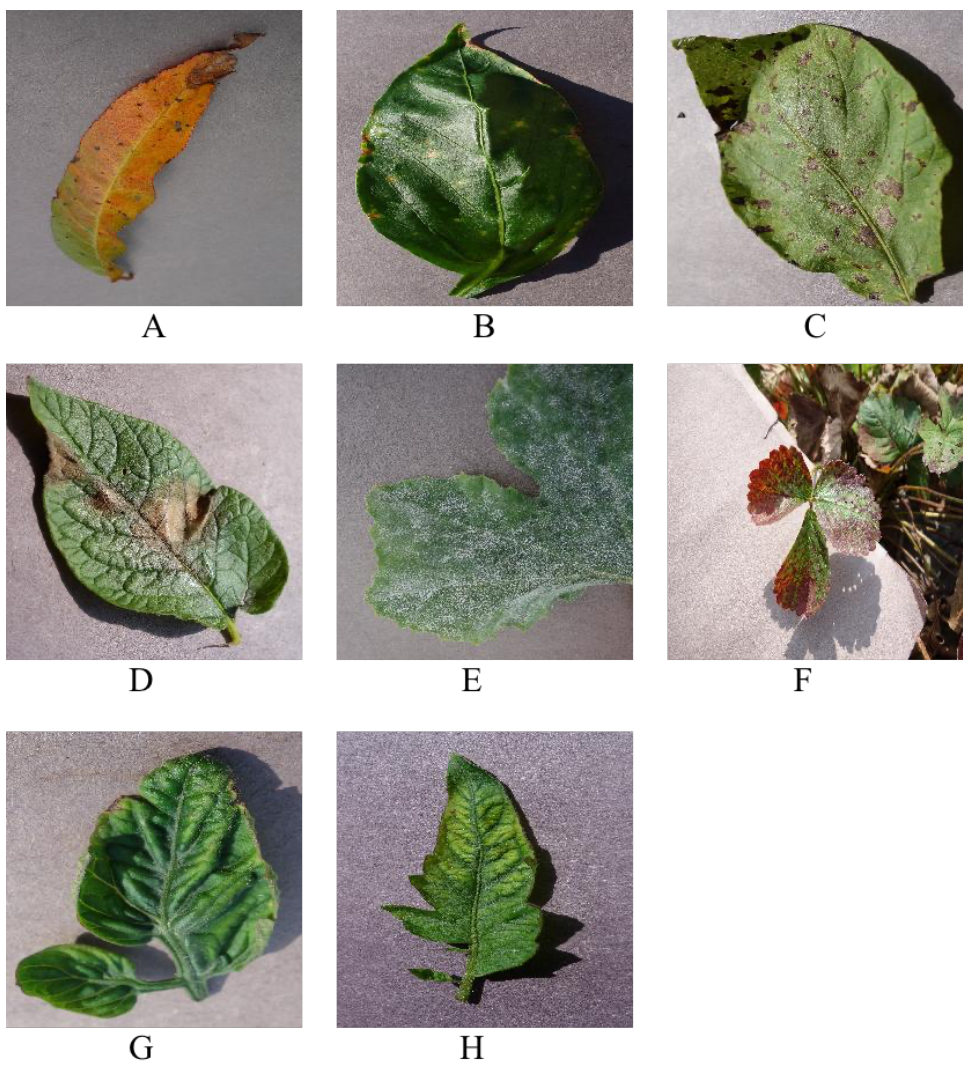
Figure 3. Illustration of disease data sets. ( A ) is peach bacterial spot, ( B ) is pepper bacterial spot, ( C ) is potato early blight, ( D ) is potato late blight, ( E ) is squash powdery mildew, ( F ) is strawberry leaf scorch, ( G ) is tomato curl virus, ( H ) is tomato mosaic virus.